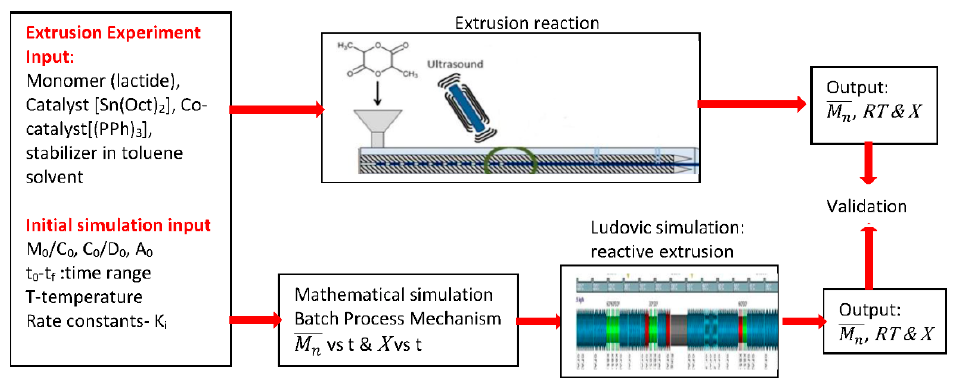
Figure 1. Methodology to explain reaction parameters. M 0 : Initial concentration of monomer, C 0 : Initial concentration of catalyst Sn(Oct) 2 , D 0 : Initial concentration of OH group source, A 0 : Initial concentration of phosphine (PPh) 3 , p M n ) number average molecular weight, X : conversion, RT: residential time, K i: rate constants.